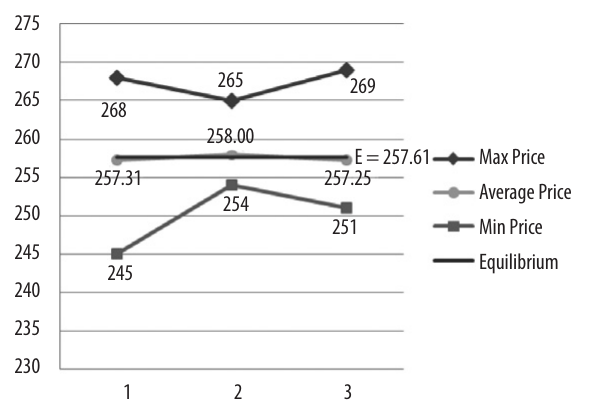
roundFig 3. Final prices of Game 2 for each